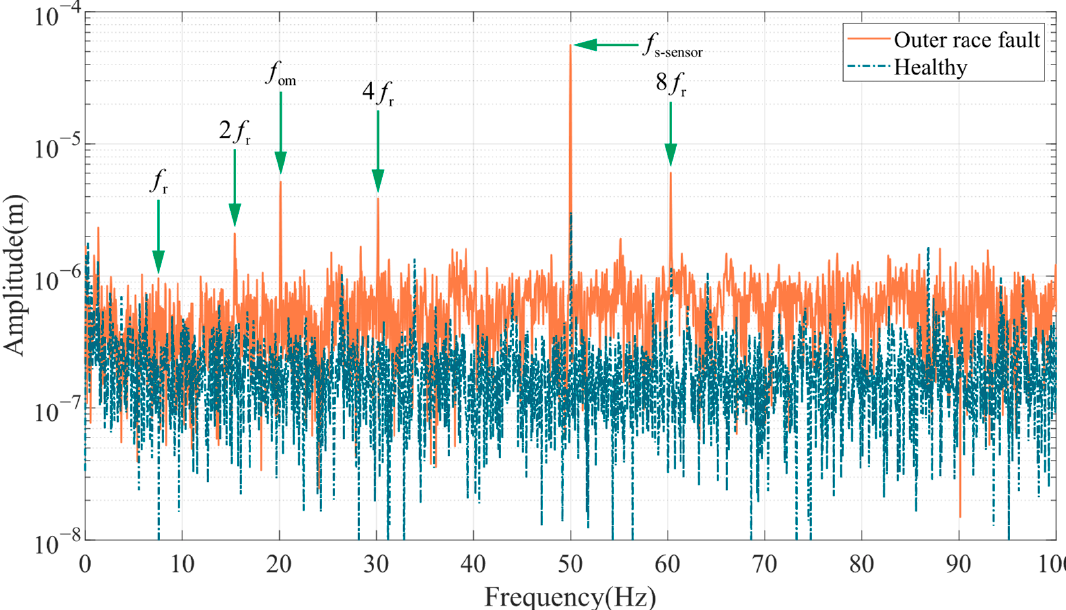
Figure 21. Comparison of vibration experiment signal spectrum of motor end cap under outer race fault (10 Hz).